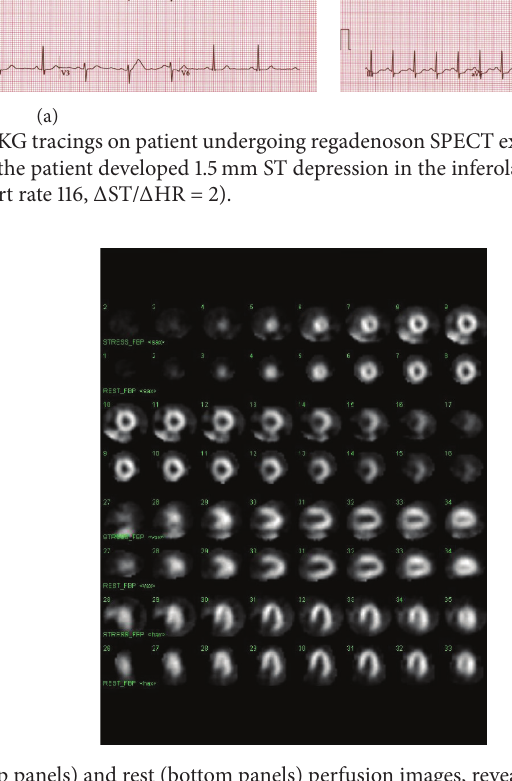
Figure 2: Gray scale stress (top panels) and rest (bottom panels) perfusion images, revealing absence of perfusion abnormality.